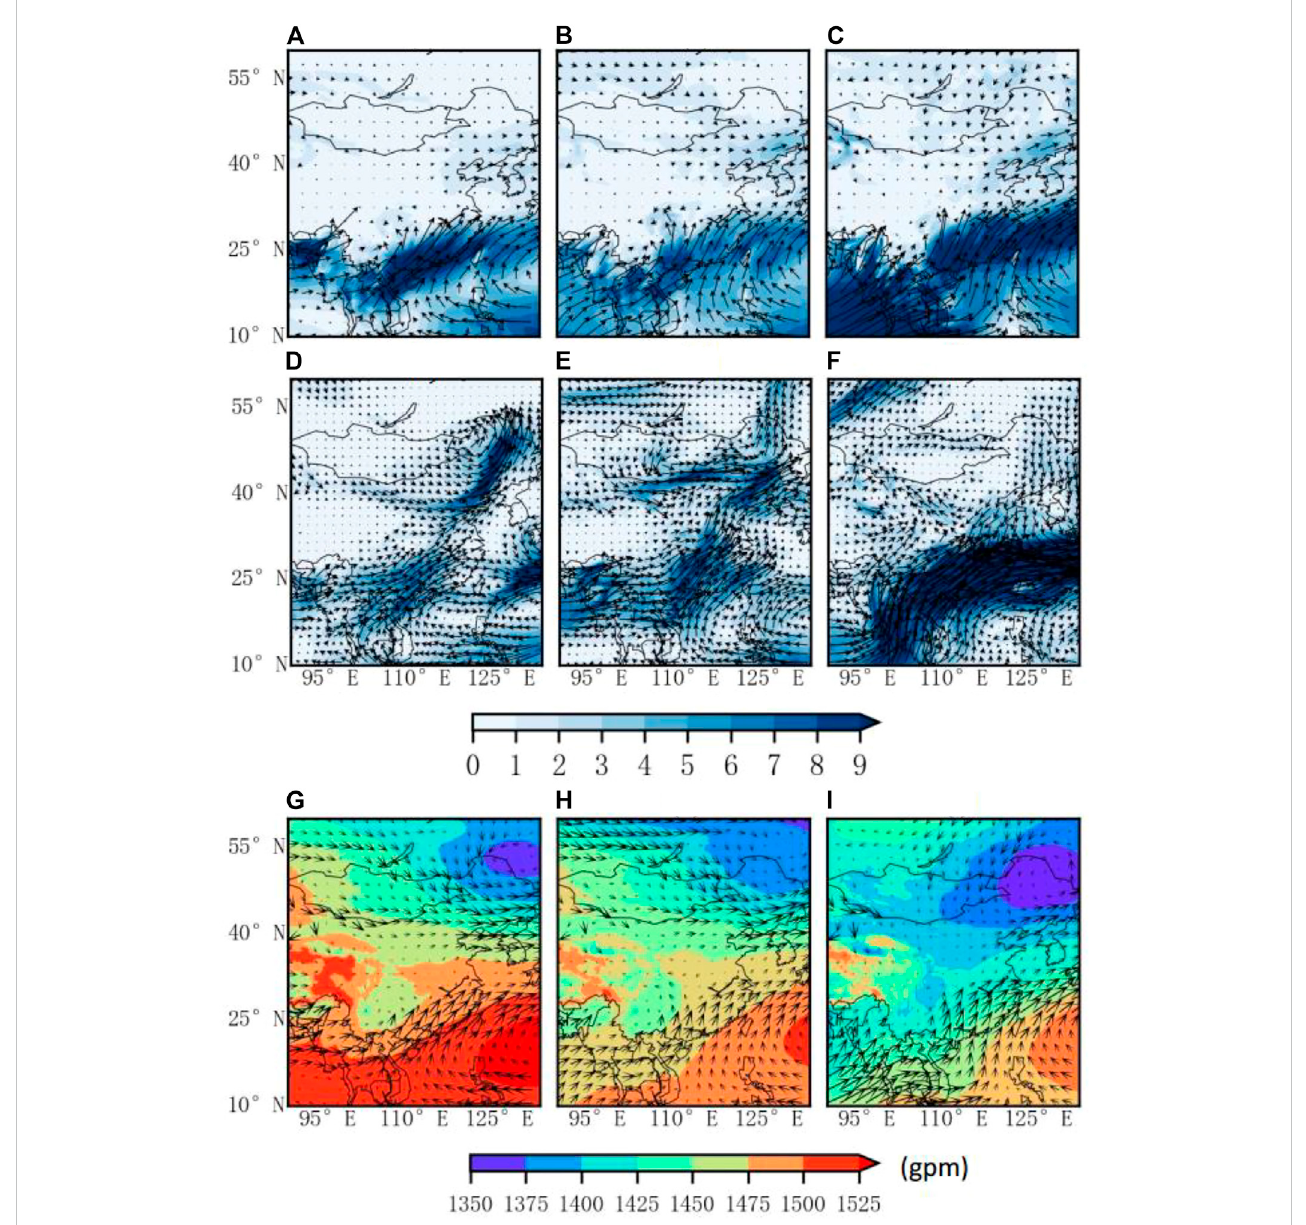
FIGURE 9 Monthly-averaged single-layer water vapor fl ux fi eld at 850 hPa (unit: g · Pa − 1 · m − 1 · s − 1 ): (A) April; (B) May; (C) June. Monthly-averaged whole-layer water vapor fl ux fi eld of 1,000 – 300 hPa (unit: g · Pa − 1 · m − 1 · s − 1 ): (D) April; (E) May; (F) June. Monthly average geopotential height (gpm) and wind vector fi eld (m/s) at 850 hPa.Thevector denotesthesizeanddirection ofwindandwater vapor fl ux,theshadingindicatesthevalueofpotential height: (G) April; (H) May; (I)